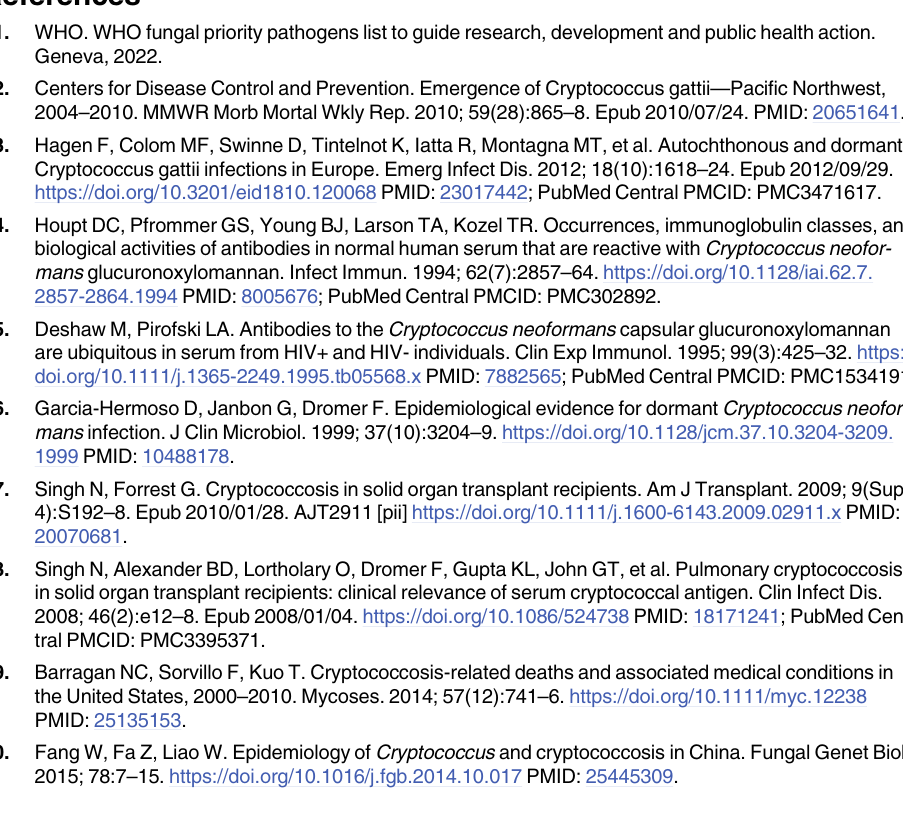
S1 Fig. Flow chart of the steps towards a cryptococcal vaccine.